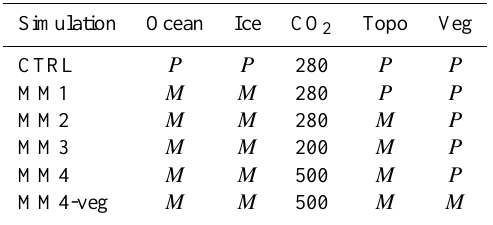
Table 1. Description of the simulation experiments. P refers to preindustrial conditions and M refers to Miocene conditions. Each one of the five columns corresponds to each of the five modified boundary conditions: ocean heat transfer, ice-sheet cover, atmo- spheric CO 2 concentration (inppmv), topography and vegetation